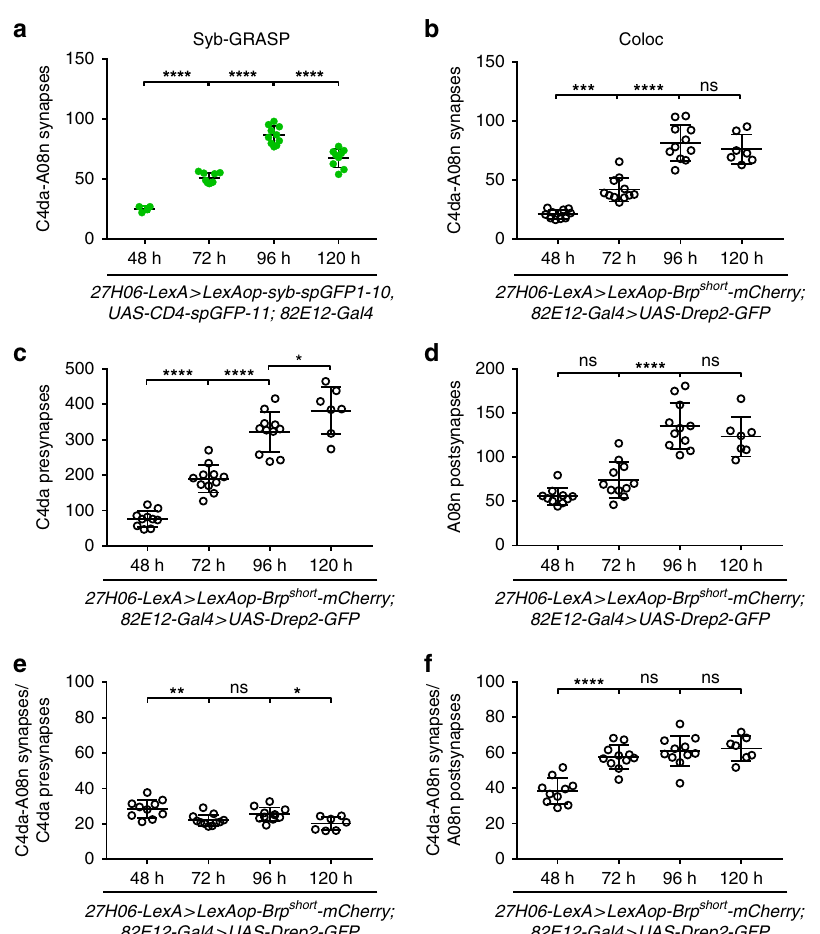
Fig. 2 Scalar increase of C4da – A08n connectivity during larval growth. a Quanti fi cation of C4da – A08n synapses during development from 48 h AEL until 120 h AEL with Syb-GRASP. 48 h: n = 4, 72 h: n = 10, 96 h: n = 10, 120 h: n = 9. **** P < 0.0001. ANOVA with multiple comparisons and Sidak ’ s